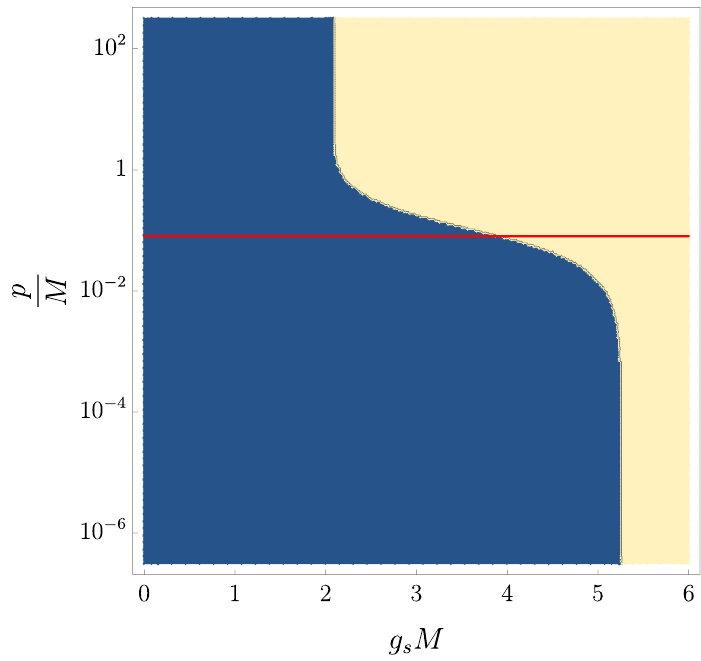
JHEP10(2022)166 Figure 4. The space of curvature-corrected KPV setups, parameterized by g s M and p/M . The regions where the maximum of the potential is at positive/negative value are coloured yellow/blue. For p/M (cid:28) 0 . 1 the boundary line asymptotes towards g 5 . 238 and for p/M (cid:29) 0 . 1 towards s M → g s M → 2 . 086 . The red line is at p/M = 0 . 08 , approximately above which the maximum is at stringy or substringy radii for the NS5-brane and hence not